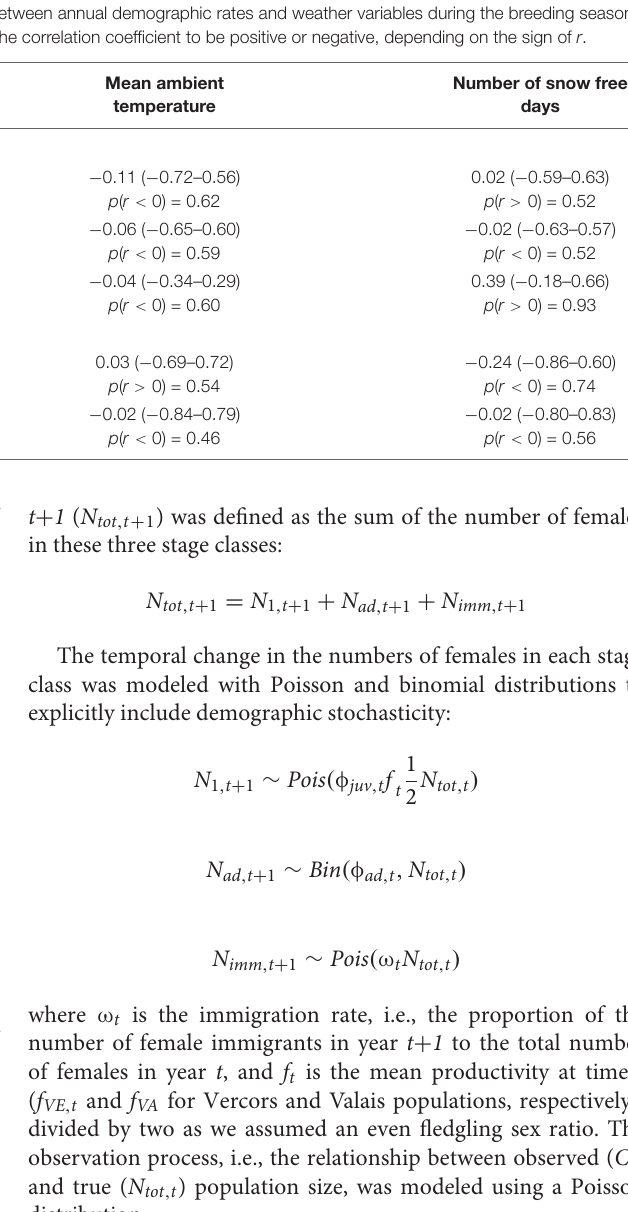
Number of snow free temperature